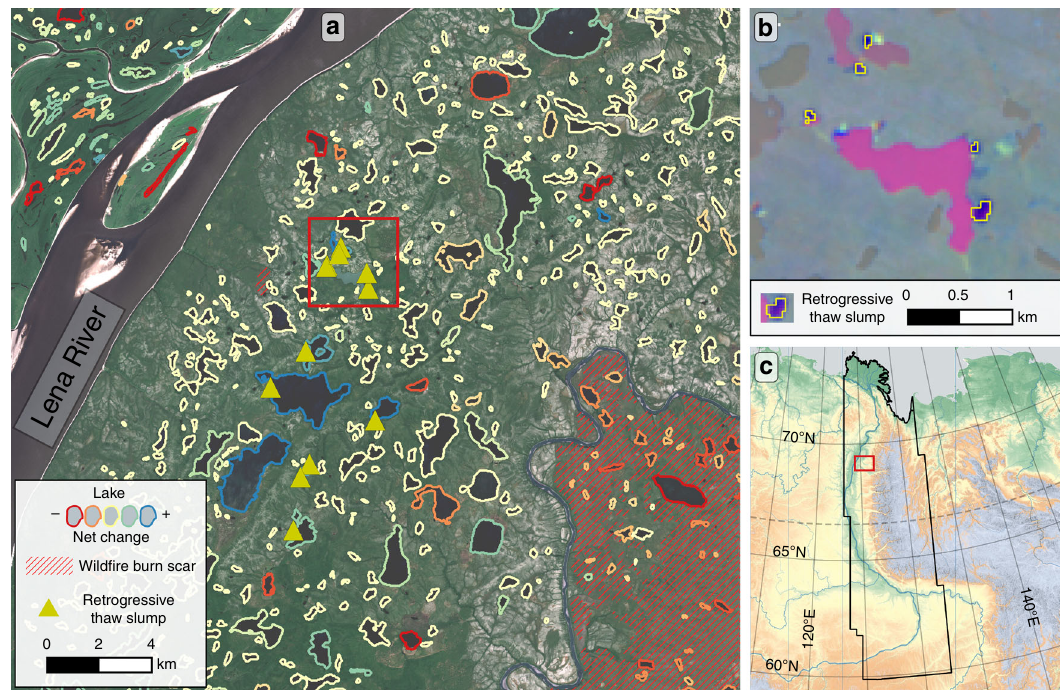
Fig. 5 Local example of lake changes, retrogressive thaw slumps, and wild fi re burn scars along the Lena River in northeastern Siberia. a Lake perimeters with net change direction and location of retrogressive thaw slumps (RTS) and wild fi re burn scars, b Detailed view of Landsat trend images with RTS perimeters indicated along lake shores. Magenta color indicates strong increase in suspended sediments within the lake, c Location of example within East Siberian Transect. Approximate Location: 69.13°N, 124.45°E. Background image a Sentinel-2 image acquired on July 2, 2018. Background image b Landsat Trend Analysis Tasseled Cap Visual Product 64 . Background image c GTOPO30 DEM overlain by MapSurfer ASTER GDEM-SRTM Hillshade layer accessed through QGIS QuickMapServices